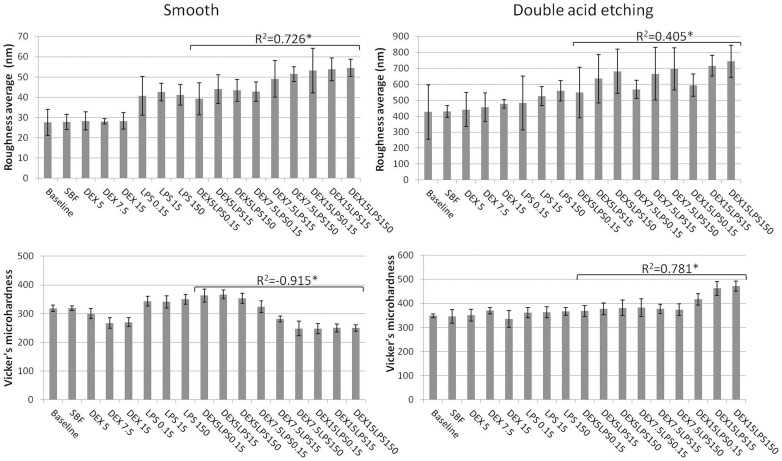
Data on surface topography.Means and standard deviations of surface roughness (Ra) (in nm) and Vickers microhardness for the Ti-6Al-4V alloys with a smooth surface and those etched with acid in SBF with different concentrations of dextrose (DEX) and lipopolysaccharide (LPS), alone or in combination (DEXLPS). * Denotes significant correlation at the 0.05 level.